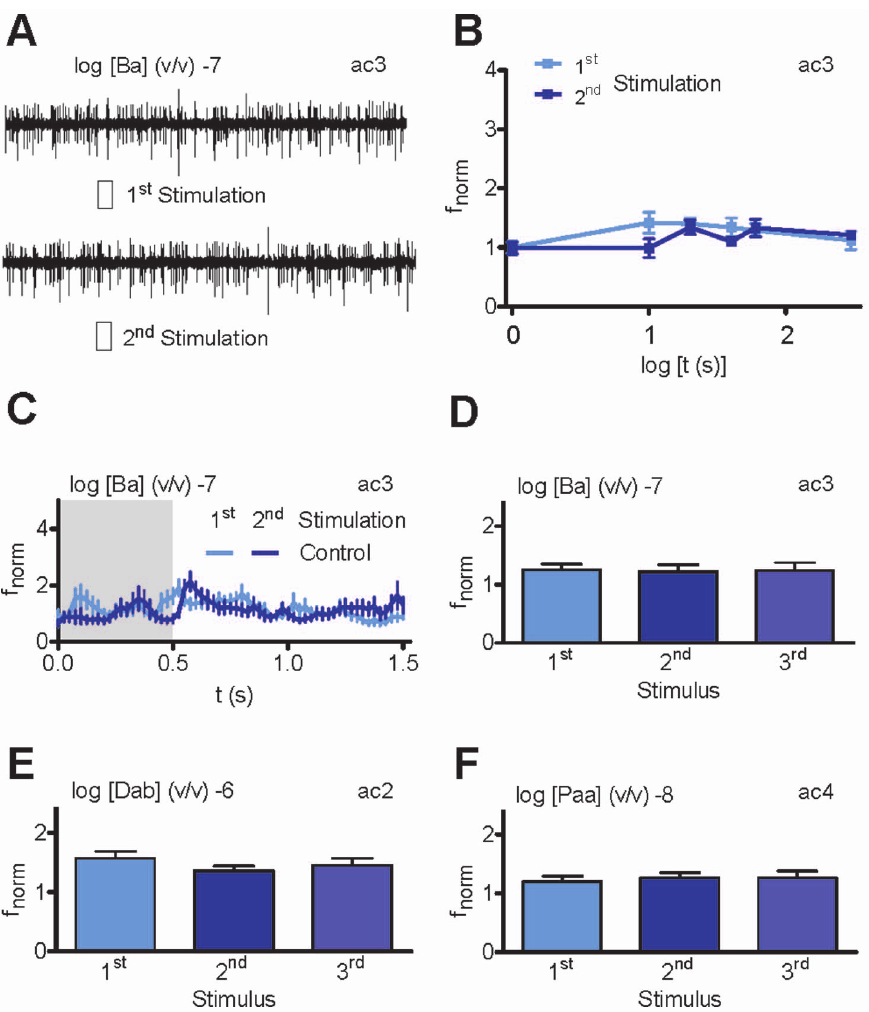
Figure 2. Repeated subthreshold stimulation does not sensitize ionotropic receptors (IRs). A , Recordings of neuronal activity from ac3 sensilla (large action potentials, Ir75abc neuron; small action potentials, Or35a neuron) upon before and after 20 s repeated butyric acid (Ba) stimulation ( 2 7 v/v; 0.5 s, shaded area). Both stimulations fail to elicit a response. B , Dependence of normalized Ir75abc neuron spike frequency (f norm ) during 1 st and 2 nd subthreshold Etb stimulation ( 2 7 v/v; 0.5 s) on the interval between stimulations ( n =12). C , Time course of f norm for 1 st and 2 nd stimulation (interval 20 s, n =12). D–F , Mean f norm for Ir75abc ( D ), Ir41a ( E ) and Ir84a ( F ) neuron to repetitive subthreshold Ba ( D ), Dab ( E ) and Paa ( F ) stimulations (interval 20 s, n =12). N.s.; Paired Wilcoxon Signed Ranks test.